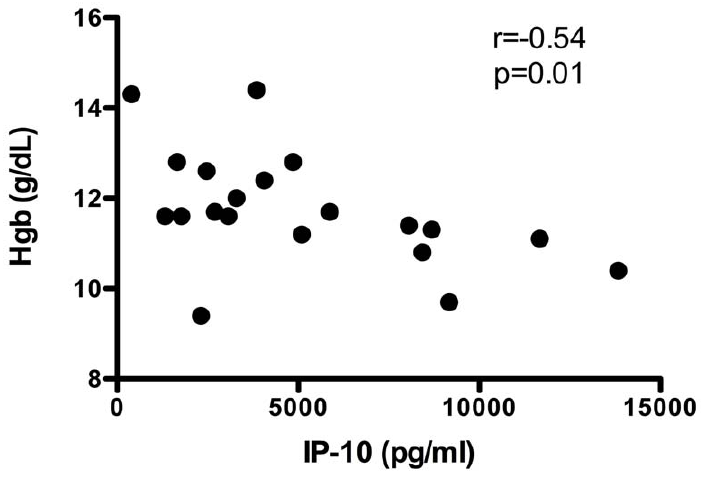
Figure 7. Negative correlation between serum levels of IP-10 during acute malaria and Hgb levels at the peak of malaria transmission. The symbols represent the values for individual study